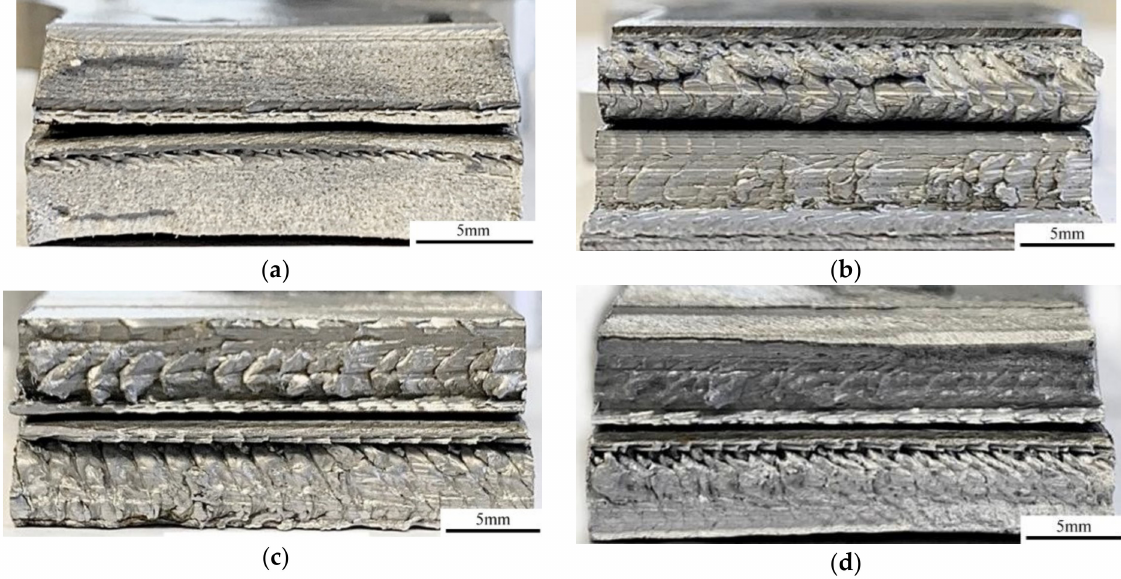
Figure 8. Fractographic images: ( a ) CR6; ( b ) CR7; ( c ) CW3; ( d )